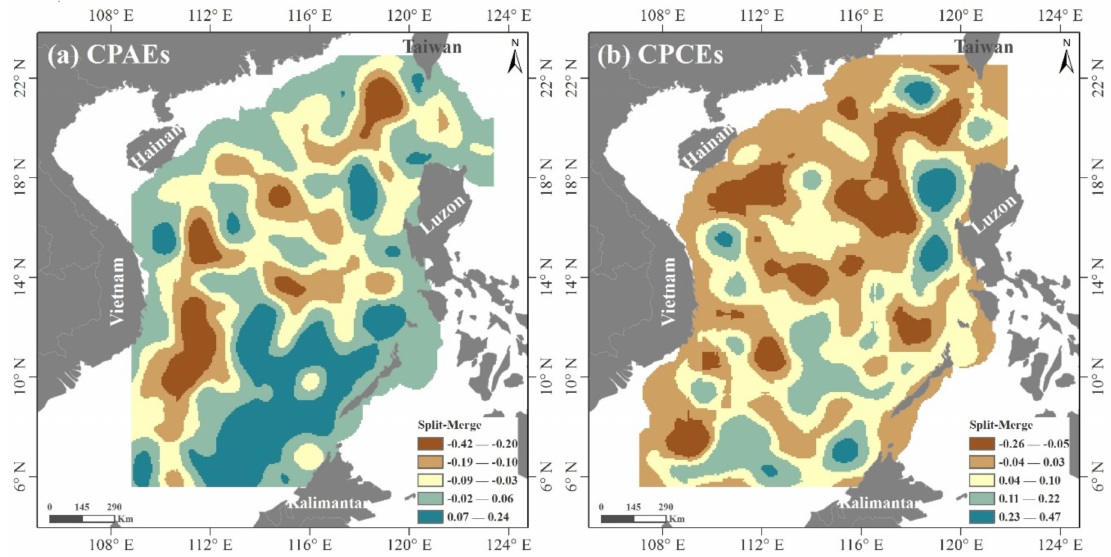
Figure 7. The kernel density di ff erence between the splitting and merging feature points of CPAEs ( a ) and CPCEs ( b ).